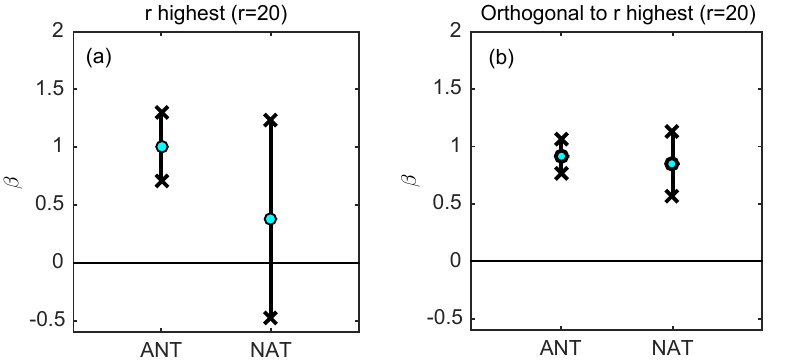
Figure 4. Illustration of temperature data with r = 20. (a) Regression coefficients β ANT and β NAT estimated using the conventional estimator b β r : value of the estimate (green dots) and 95% confidence interval (thick black lines). (b) Same as (a) under the proposed estimator b β